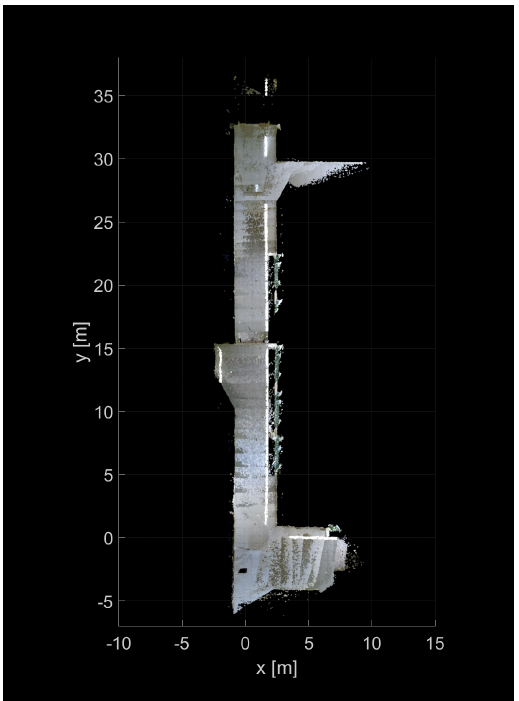
Figure 4. Top view of the 3D reconstruction of the considered corridor.